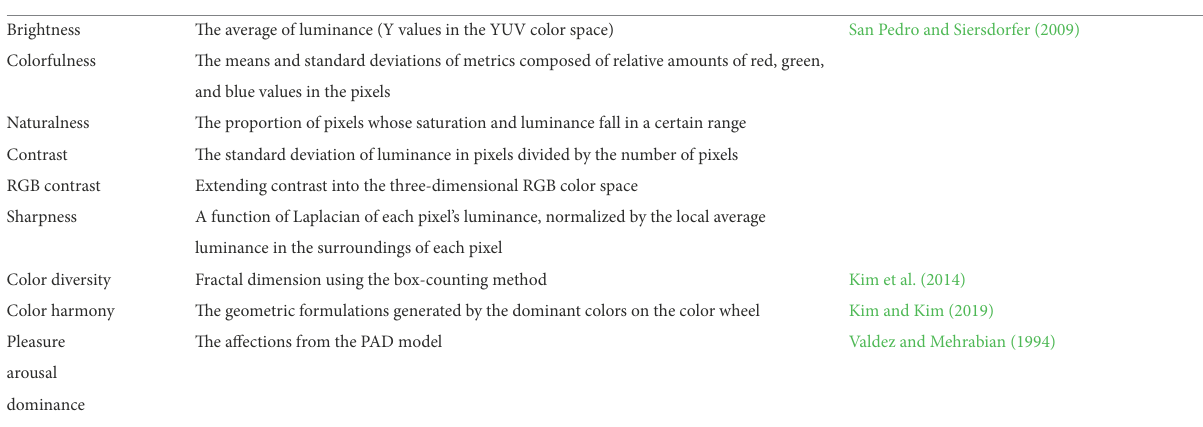
TABLE 2 Summary of visual